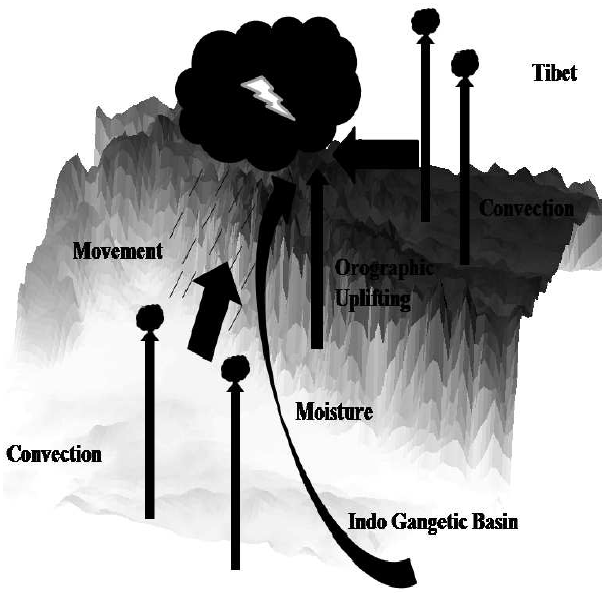
Figure 11. Conceptual model of the key meteorological elements that led to the cloudburst over Uttarkashi on 3 August